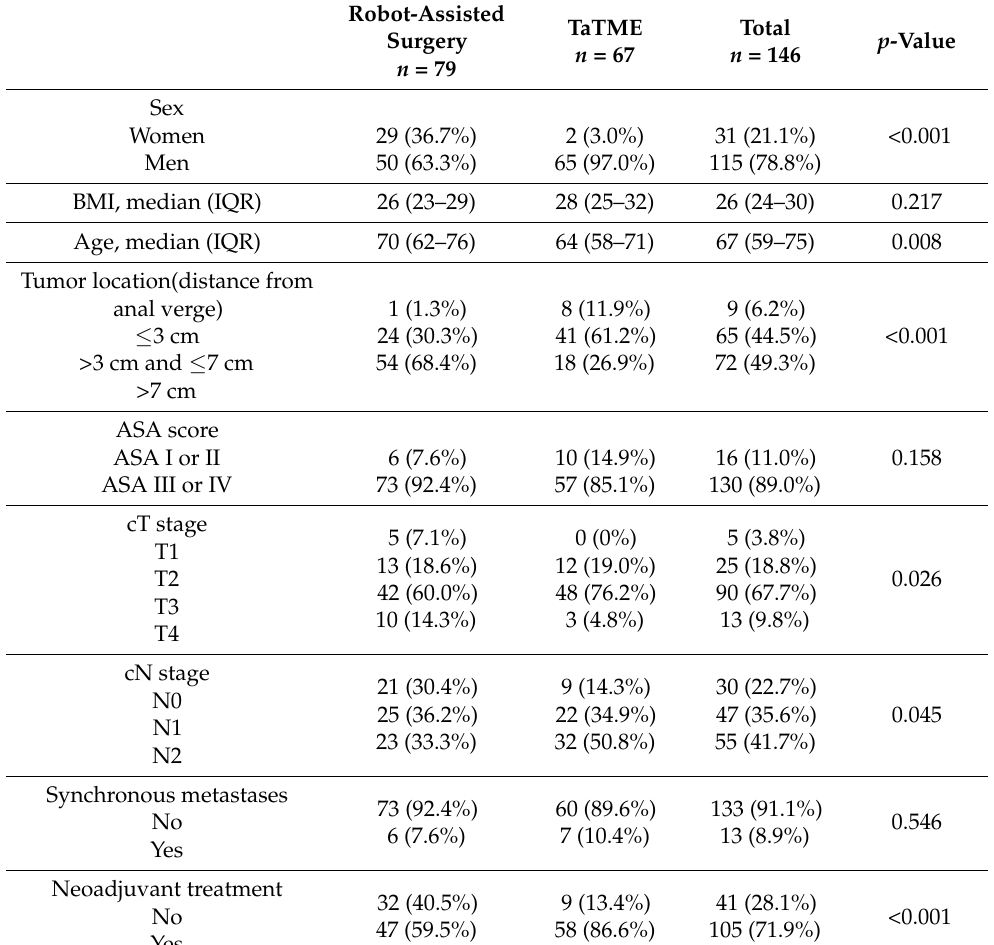
Table 1. Baseline characteristics of patients who underwent taTME or robot-assisted surgery for rectal